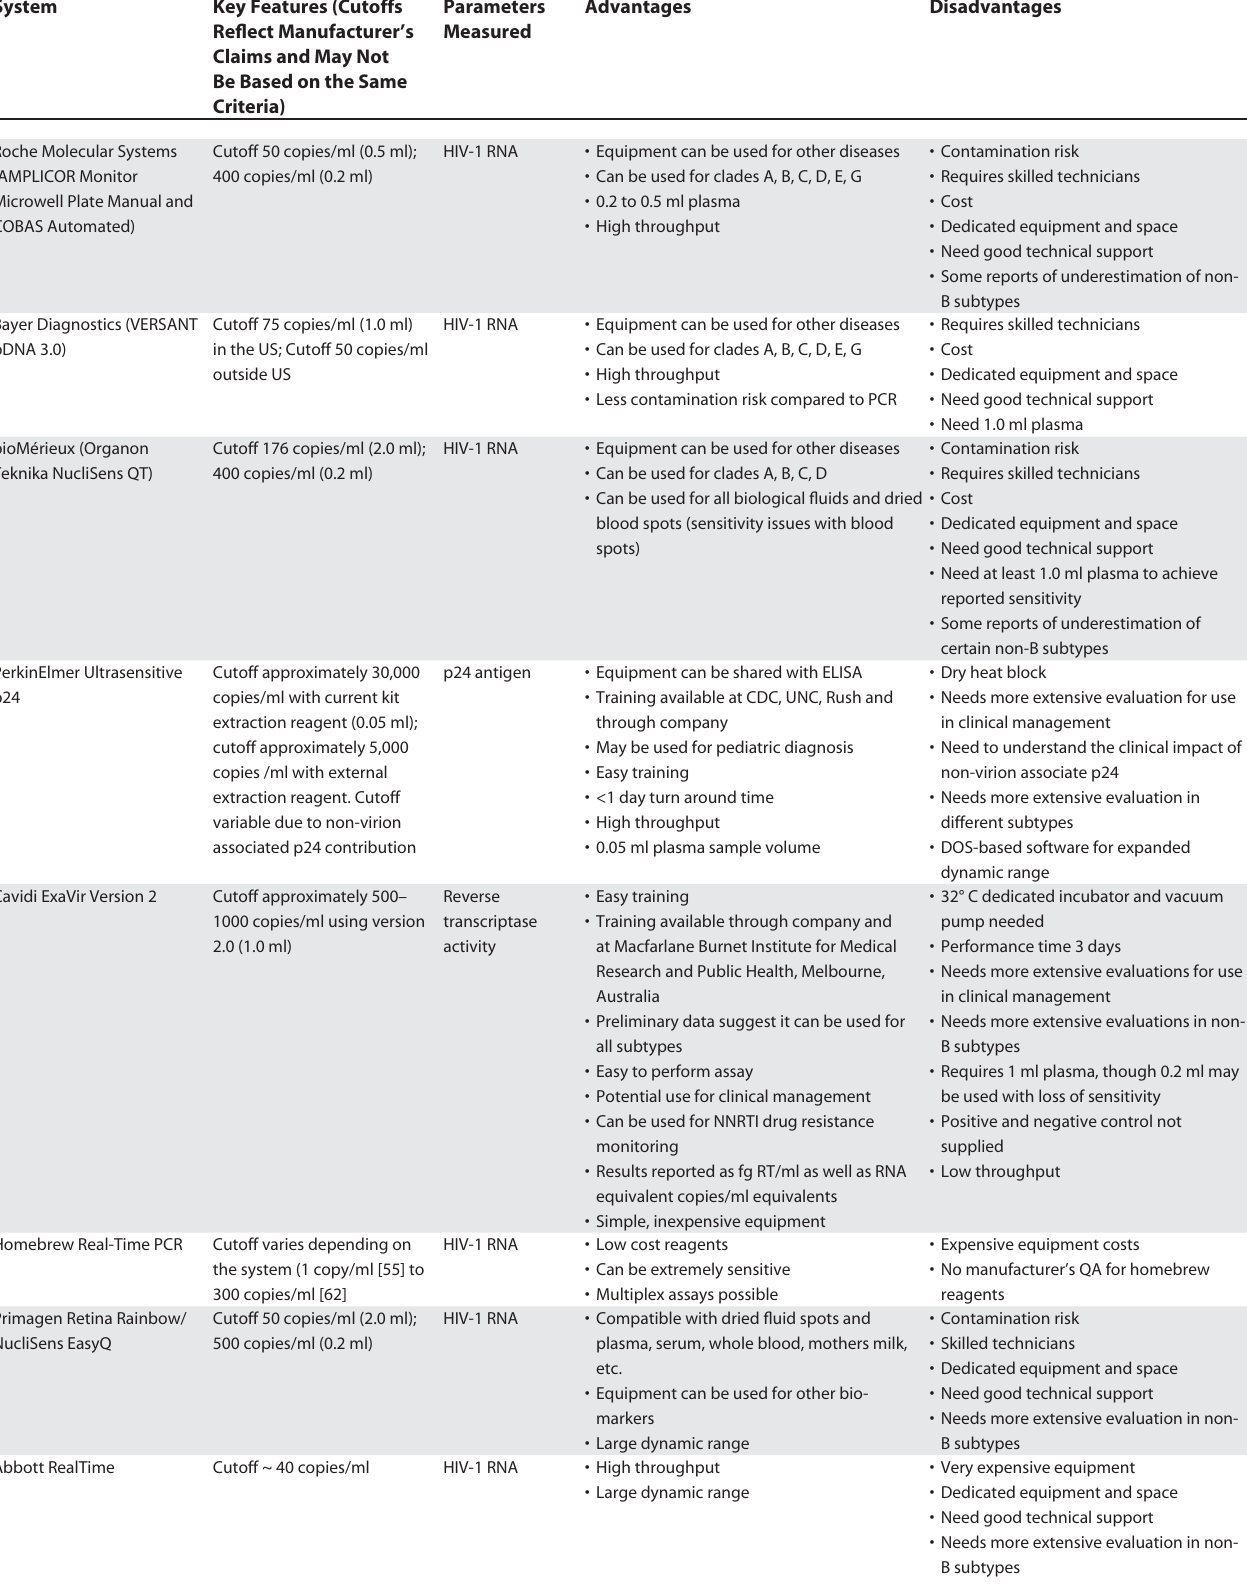
Table 1. Summary of Commercially Available Viral Load Assays